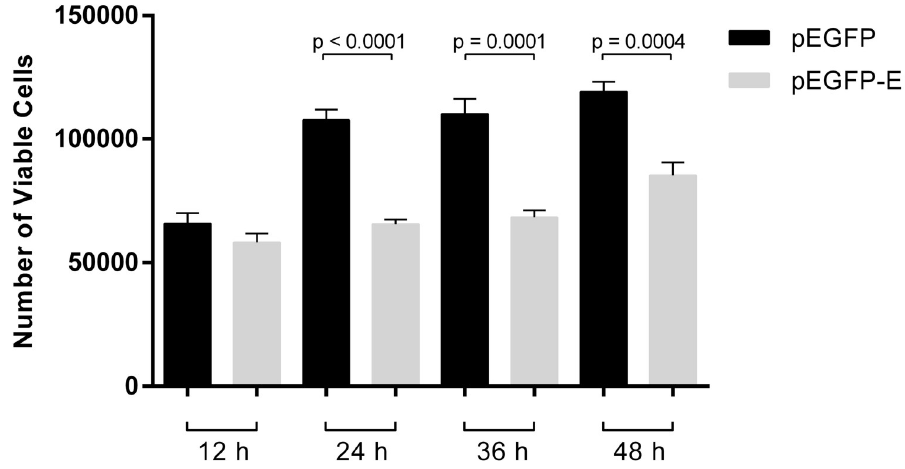
Fig 2. HPV16 E1 decreases cell growth. Cell viability was quantitated using trypan blue. Statistically significant cell growth reduction was observed in pEGFP-E1 transfected cells at 24, 36, and 48 hours